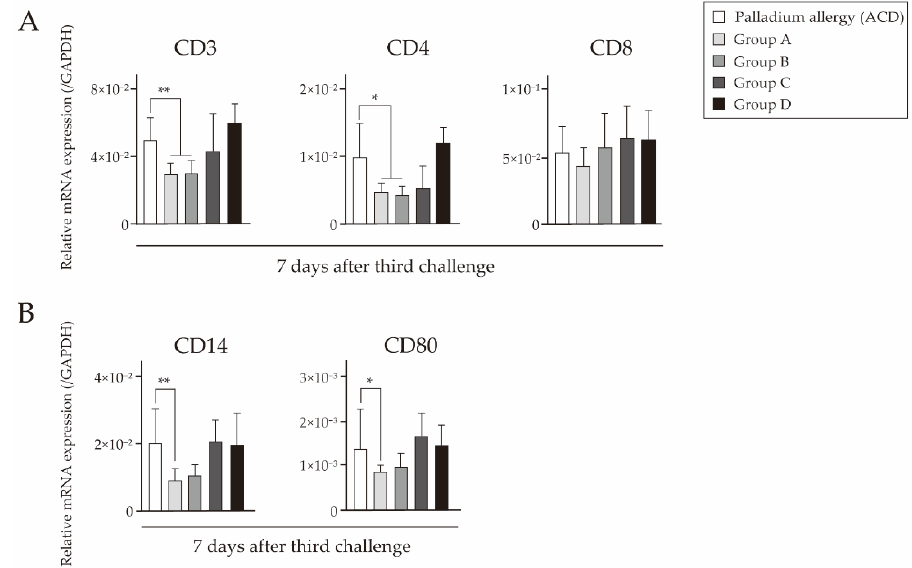
Figure 6. Effects of fexofenadine hydrochloride on mRNA expression levels indicating T cell phenotypes and T cell-related markers in Pd-induced ACD mice. Messenger RNA (mRNA) expression levels of CD3, CD4, CD8 ( A ), CD14, and CD80 ( B ) in footpads were assessed at 7 days after challenge. Glyceraldehyde-3-phosphate dehydrogenase (GAPDH) gene expression was used as an internal control. Bars and error bars indicate the mean + standard deviation (SD). Statistical significance was tested by the unpaired Mann Whitney test. * p < 0.05 is considered as significant and ** p < 0.01 is considered as very significant.